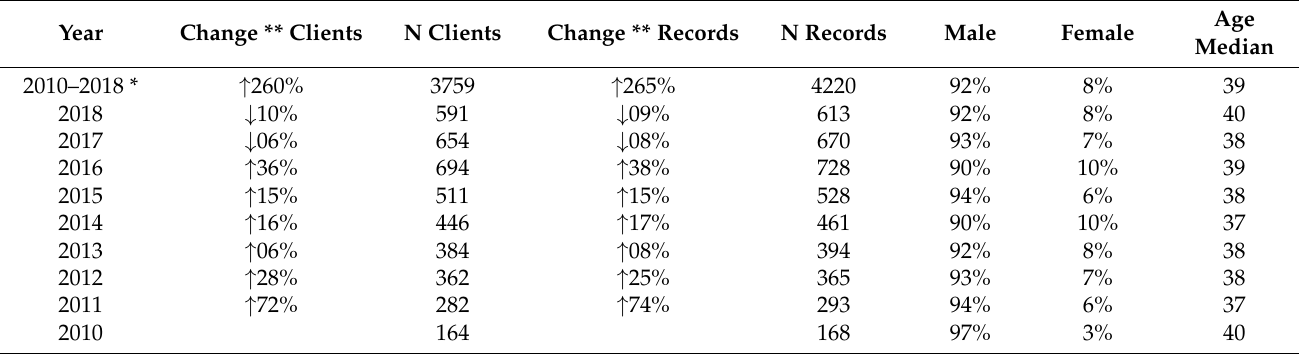
Table 1. Percentage of change, number of clients and records, gender distribution, and median age per year as recorded in the Queensland MATES case management database.